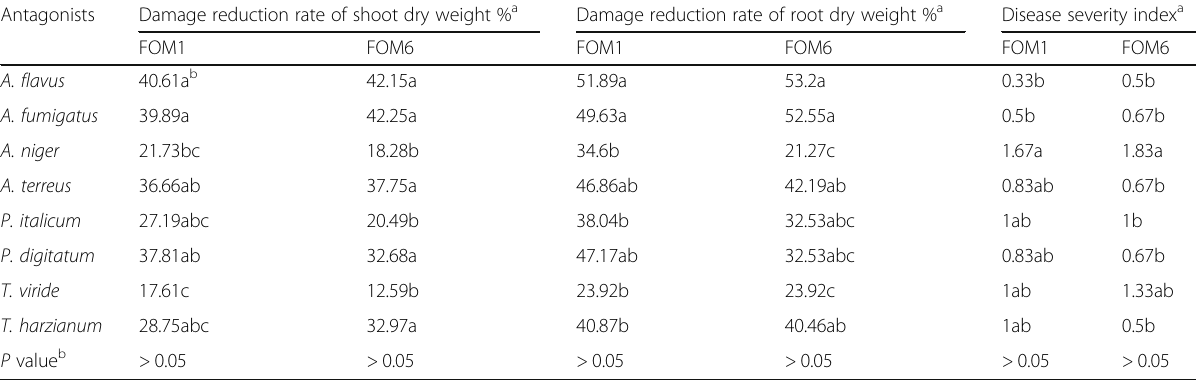
Table 5 Damage reduction rate of shoot and root dry weight (%) and disease severity index values recorded by melon seedlings inoculated with two F. oxysporum f. sp. melonis isolates and treated preventively by four Aspergillus spp. isolates, two Penicillium spp. isolates, and two Trichoderma spp. in vivo assay